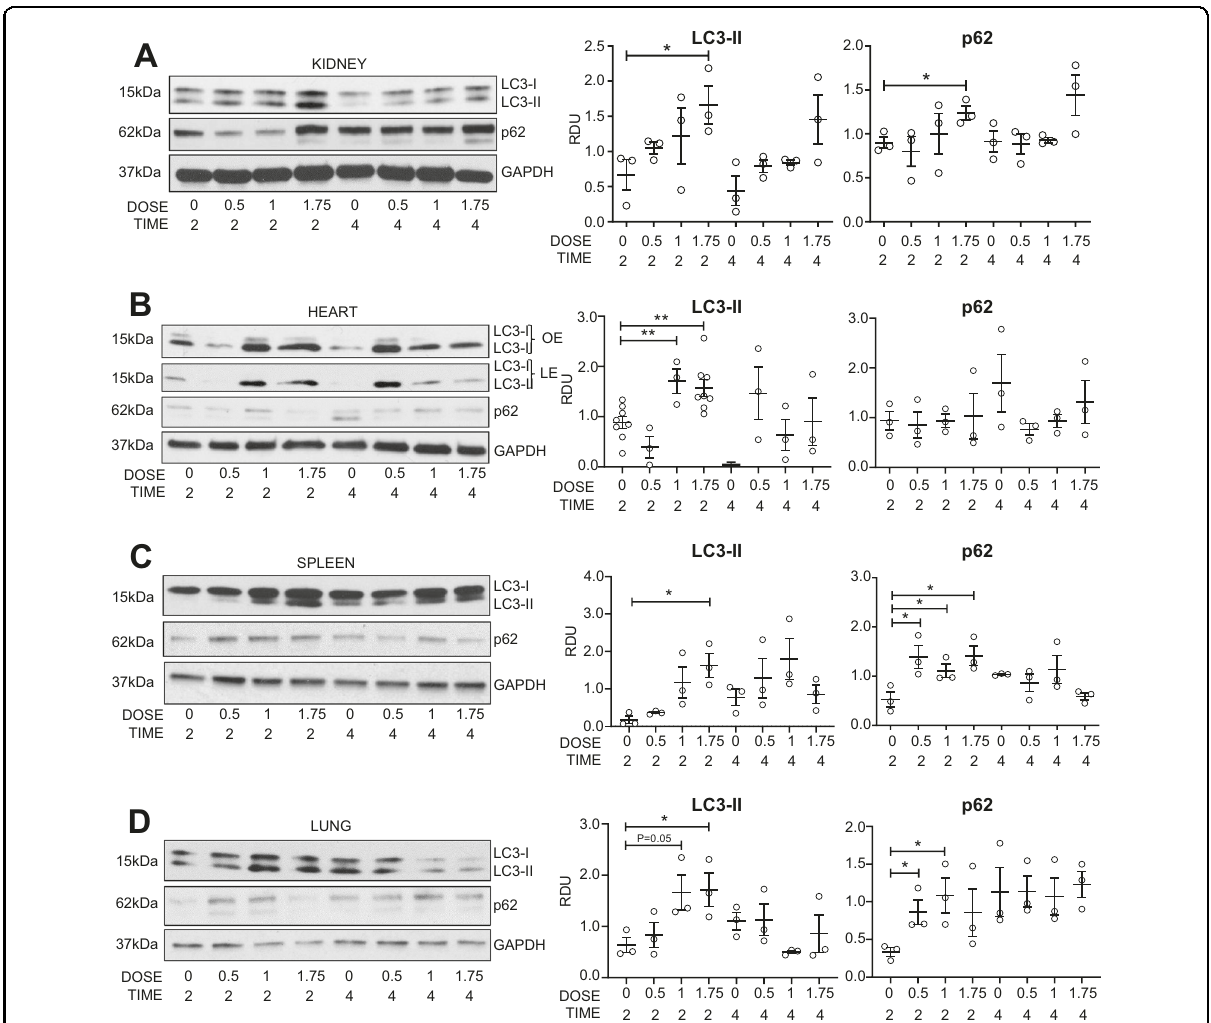
Fig. 3 Autophagic fl ux in the normal kidney in vivo. A dose (mg/kg) and time (hours) study was performed for the lysosomal inhibitor, BafA1, in vivo. LC3-II and p62 were measured by immunoblot analysis in the A kidney, B heart, C spleen and D lungs. * P < 0.05, ** P < 0.01. OE = over exposure, LE = light exposure, RDU = relative densitometry units corrected for